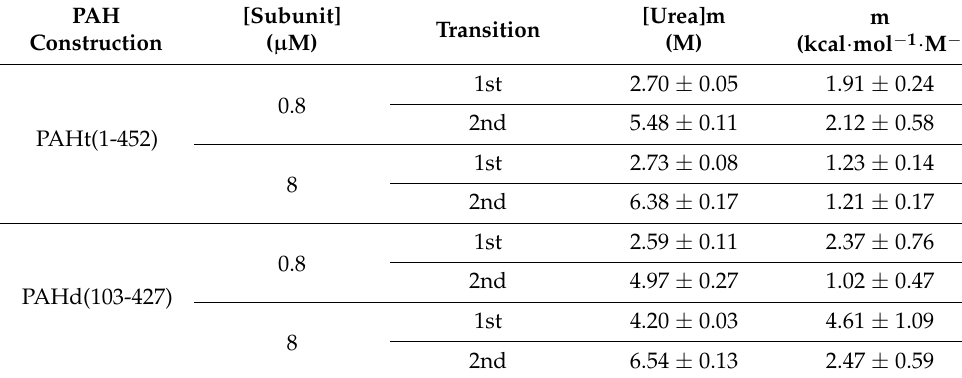
Table 1. Apparent thermodynamic parameters of urea-induced unfolding equilibrium of the human PAH protein. Reported values of m and [urea]m correspond to the result of global nonlinear fitting to a three-state model of two or three chemical unfolding curves for each construction at the different protein concentrations indicated. The errors indicated are those obtained in the global nonlinear